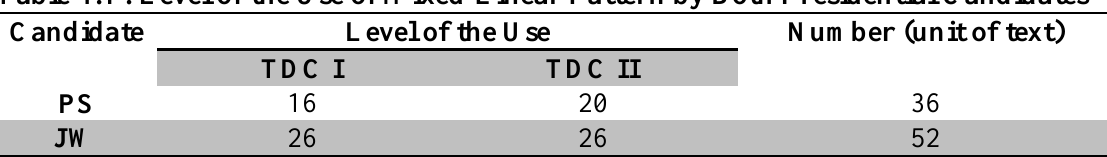
Table 4.4 : Level of the Use of Mixed-Linear Pattern by Both Presidential Candidates